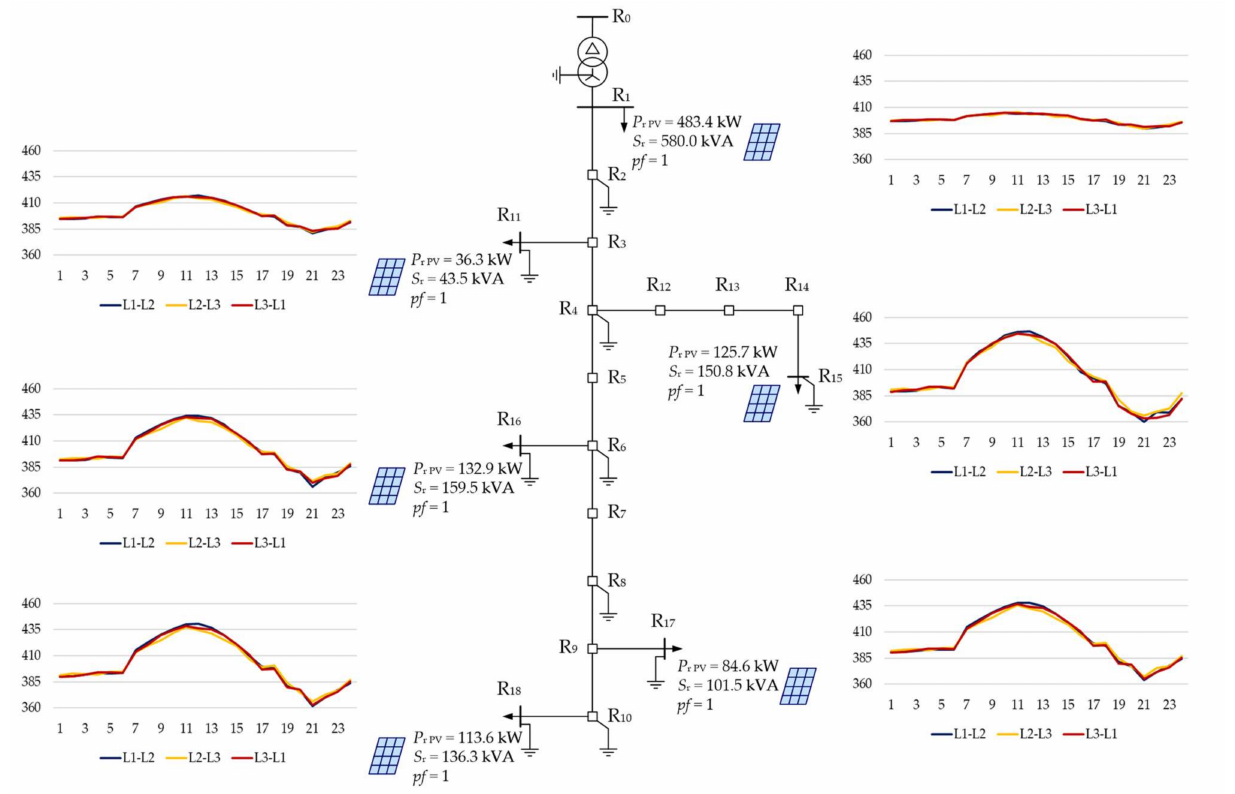
Figure A9. Daily simulation results for variant V8: phase-to-phase voltages (V).